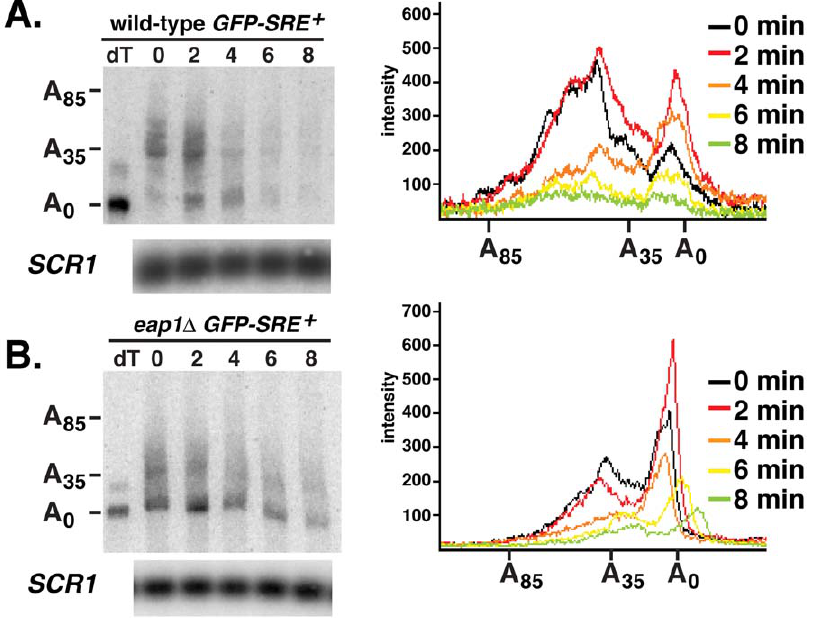
Figure 4. Eap1p is not required for transcript deadenylation. GFP-SRE + reporter transcription in wild-type cells ( A ) and eap1 D cells ( B ) was induced with galactose and then shut off with glucose and an RNase H cleavage assay was used to measure the poly(A) tail length of the reporter transcript at the times indicated after transcriptional shutoff. Where indicated oligo(dT) was added to remove the poly(A) tail by RNase H treatment, providing a marker for deadenylated mRNA (dT). The distribution of poly(A) tail lengths at the indicated times after transcriptional shutoff are displayed on the graphs. An aliquot of each RNA sample was resolved in a separate Northern analysis and probed for SCR1 RNA to serve as a control for loading and RNA